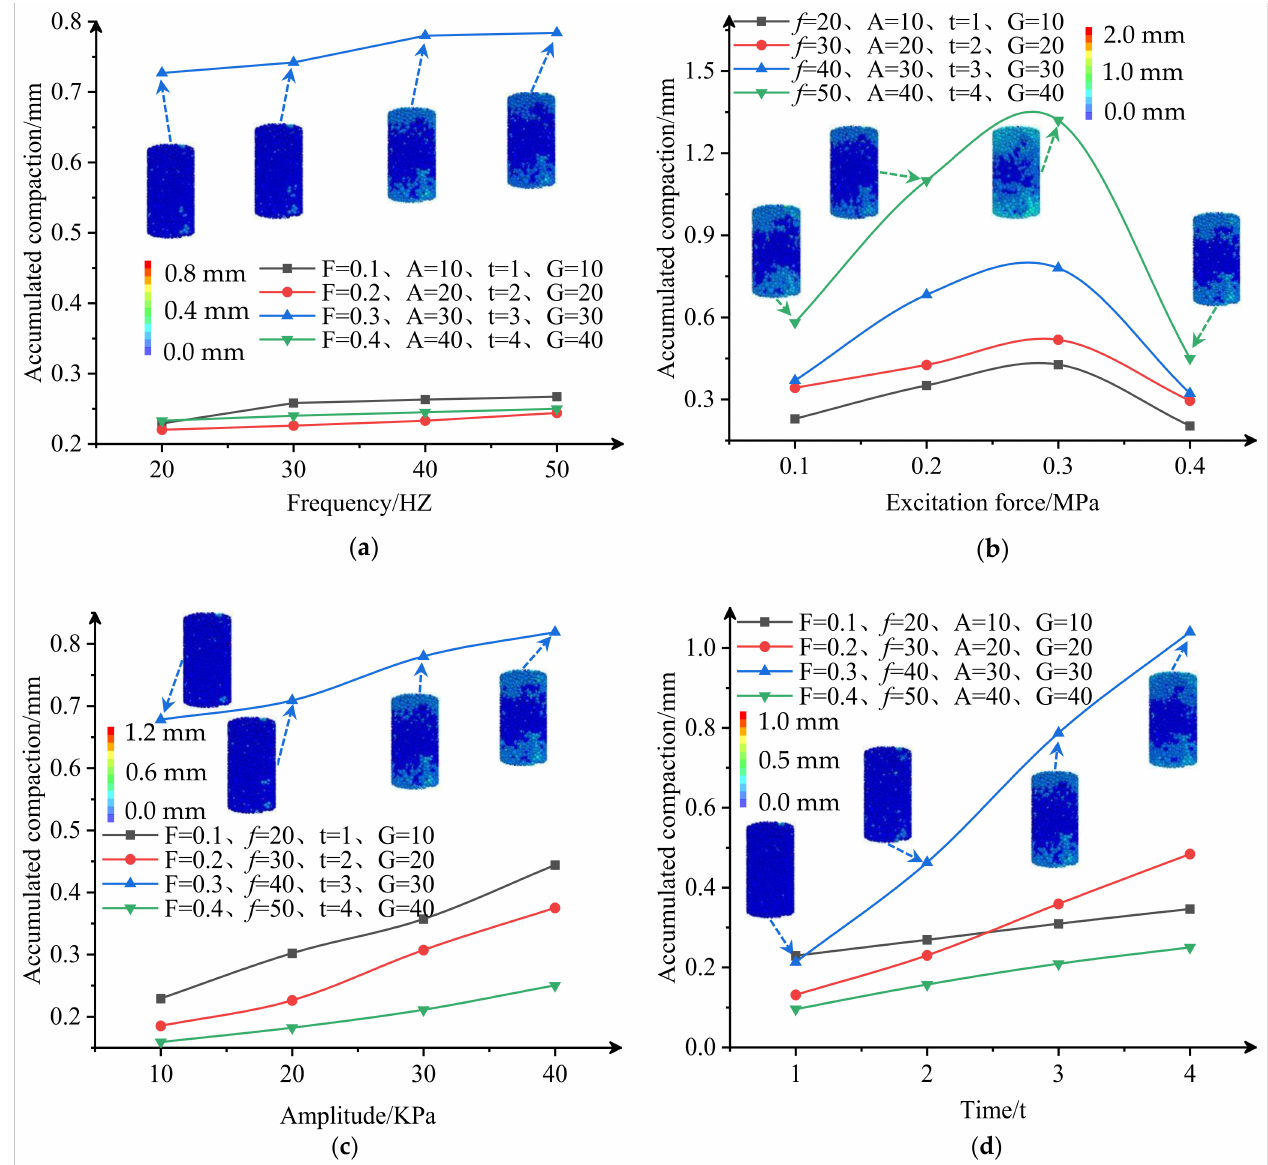
Figure 15. Change of accumulated compaction; ( a ) Amount of compaction varies with frequency (x-axis shows the frequency, y-axis shows the compaction amount); ( b ) Amount of compaction varies with excitation force (x-axis shows the excitation force, y-axis shows the compaction amount); ( c ) Amount of compaction varies with amplitude (x-axis shows the amplitude, y-axis shows the compaction amount); ( d ) Amount of compaction varies with vibration time (x-axis shows the vibration time, y-axis shows the compaction